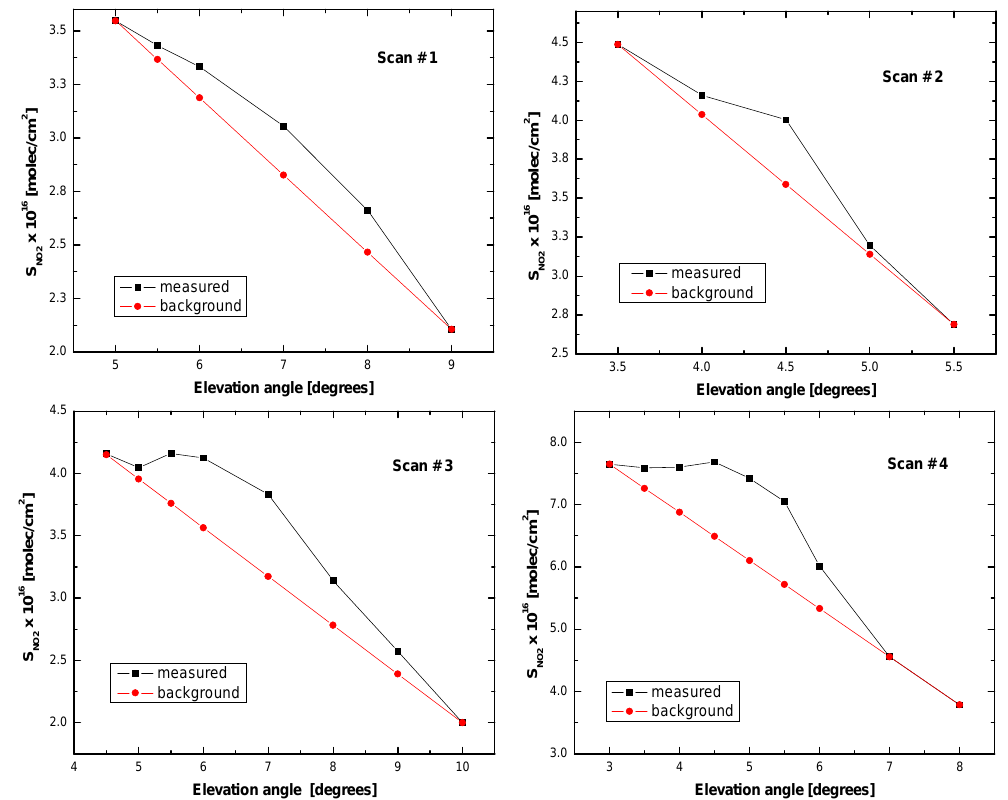
Fig. 4. Illustration of the estimation of the lower limit for the contribution of the emission plume to the measured NO 2 SCDs for scans #1–4. It is assumed that the possible contribution from the background causes a smooth variaion of the SCDs (approximated) by the red line. The difference of the measured SCDs to the red line is attributed to the emission plume (Note that for scan 1 the contribution from the emission plume is probably even smaller, because the smooth variation of the SCDs can in principle be explained by the presence of a tropospheric background